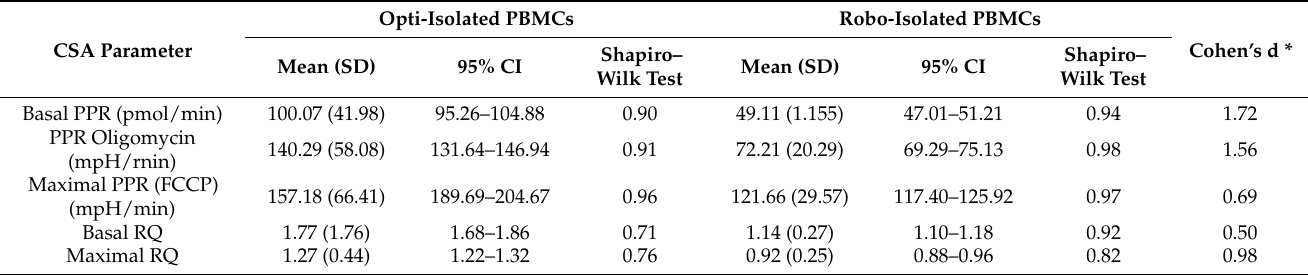
Table 2. Cellular stress assay parameters related to proton production rate and respiratory quotient in Opti-isolated ( n = 293) and Robo-isolated ( n = 185)